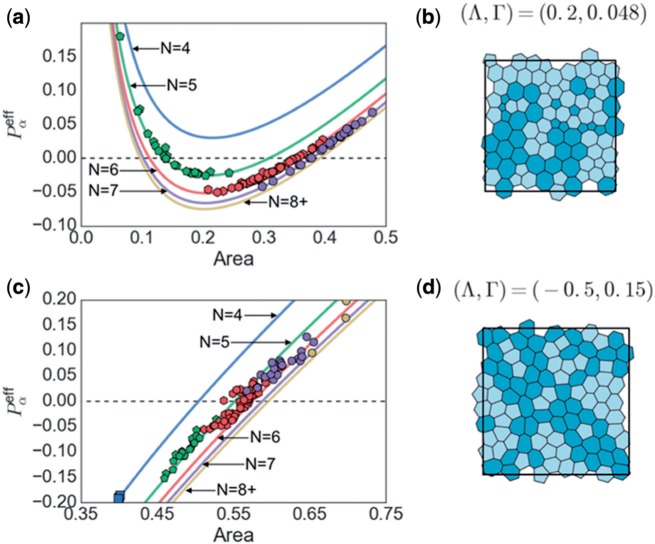
(a, c) Curves show \documentclass[12pt]{minimal}
\usepackage{amsmath}
\usepackage{wasysym} 
\usepackage{amsfonts} 
\usepackage{amssymb} 
\usepackage{amsbsy}
\usepackage{upgreek}
\usepackage{mathrsfs}
\setlength{\oddsidemargin}{-69pt}
\begin{document}
}{}$P^{\text{eff}}_N$\end{document} defined in (3.37) plotted against cell area for perfect N-gons, using \documentclass[12pt]{minimal}
\usepackage{amsmath}
\usepackage{wasysym} 
\usepackage{amsfonts} 
\usepackage{amssymb} 
\usepackage{amsbsy}
\usepackage{upgreek}
\usepackage{mathrsfs}
\setlength{\oddsidemargin}{-69pt}
\begin{document}
}{}$(\Lambda, \Gamma) = (-0.5, 0.15)$\end{document} (\documentclass[12pt]{minimal}
\usepackage{amsmath}
\usepackage{wasysym} 
\usepackage{amsfonts} 
\usepackage{amssymb} 
\usepackage{amsbsy}
\usepackage{upgreek}
\usepackage{mathrsfs}
\setlength{\oddsidemargin}{-69pt}
\begin{document}
}{}$L_0=3.33$\end{document}, a, b) and \documentclass[12pt]{minimal}
\usepackage{amsmath}
\usepackage{wasysym} 
\usepackage{amsfonts} 
\usepackage{amssymb} 
\usepackage{amsbsy}
\usepackage{upgreek}
\usepackage{mathrsfs}
\setlength{\oddsidemargin}{-69pt}
\begin{document}
}{}$(\Lambda, \Gamma) = (0.2, 0.048)$\end{document} (\documentclass[12pt]{minimal}
\usepackage{amsmath}
\usepackage{wasysym} 
\usepackage{amsfonts} 
\usepackage{amssymb} 
\usepackage{amsbsy}
\usepackage{upgreek}
\usepackage{mathrsfs}
\setlength{\oddsidemargin}{-69pt}
\begin{document}
}{}$L_0=-2.08$\end{document}, c, d). Symbols show \documentclass[12pt]{minimal}
\usepackage{amsmath}
\usepackage{wasysym} 
\usepackage{amsfonts} 
\usepackage{amssymb} 
\usepackage{amsbsy}
\usepackage{upgreek}
\usepackage{mathrsfs}
\setlength{\oddsidemargin}{-69pt}
\begin{document}
}{}$P^{\text{eff}}_\alpha$\end{document} defined in (3.24) for computationally simulated cells, with shapes displayed in (b,d). Darker (lighter) cells in (b,d) have \documentclass[12pt]{minimal}
\usepackage{amsmath}
\usepackage{wasysym} 
\usepackage{amsfonts} 
\usepackage{amssymb} 
\usepackage{amsbsy}
\usepackage{upgreek}
\usepackage{mathrsfs}
\setlength{\oddsidemargin}{-69pt}
\begin{document}
}{}$P_{\alpha}^{\text{eff}} > 0$\end{document} (\documentclass[12pt]{minimal}
\usepackage{amsmath}
\usepackage{wasysym} 
\usepackage{amsfonts} 
\usepackage{amssymb} 
\usepackage{amsbsy}
\usepackage{upgreek}
\usepackage{mathrsfs}
\setlength{\oddsidemargin}{-69pt}
\begin{document}
}{}$<0$\end{document}). (Colour in online.)